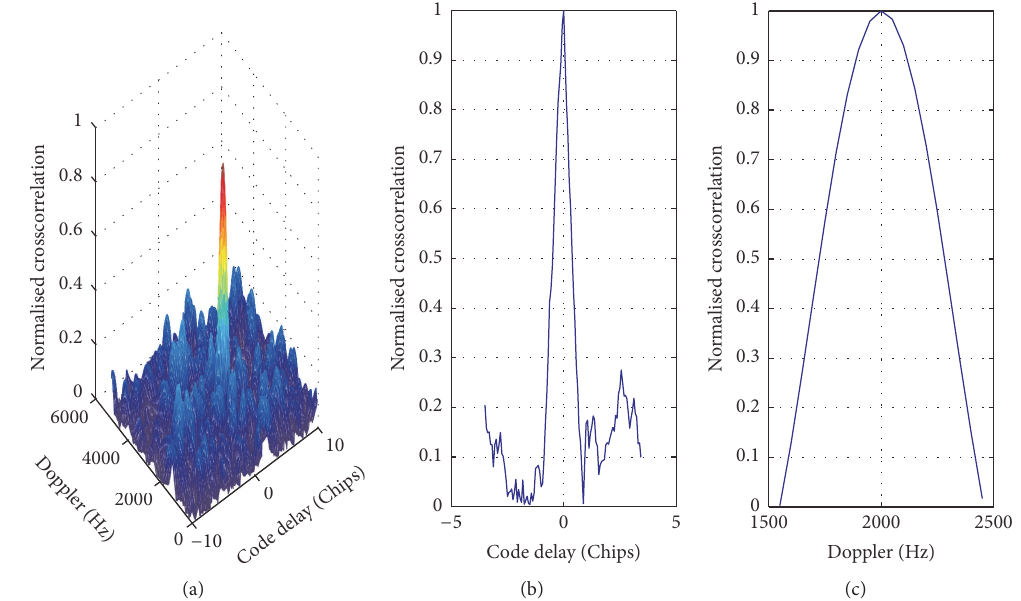
Figure 14: Correlation peaks after interference suppression by the proposed method for scenario 3.